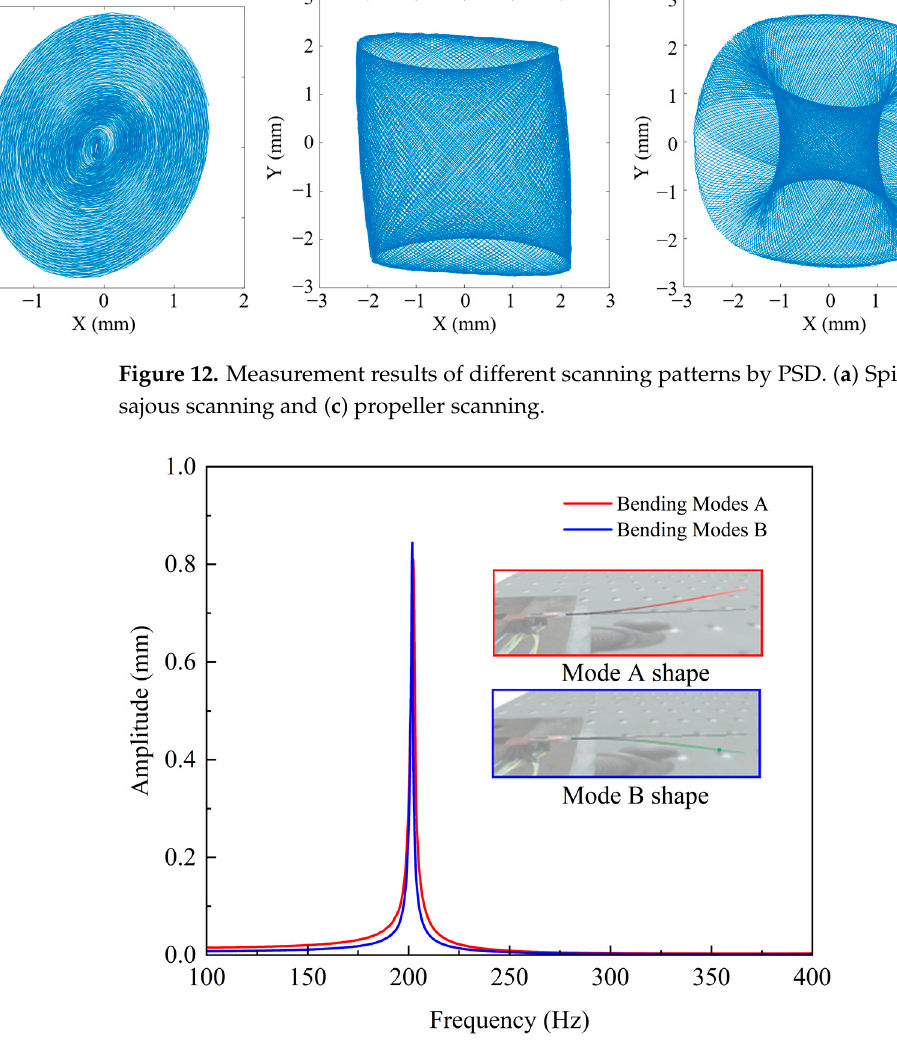
Figure 12. Measurement results of different scanning patterns by PSD. ( a ) Spiral scanning, ( b ) Lis- sajous scanning and ( c ) propeller scanning.